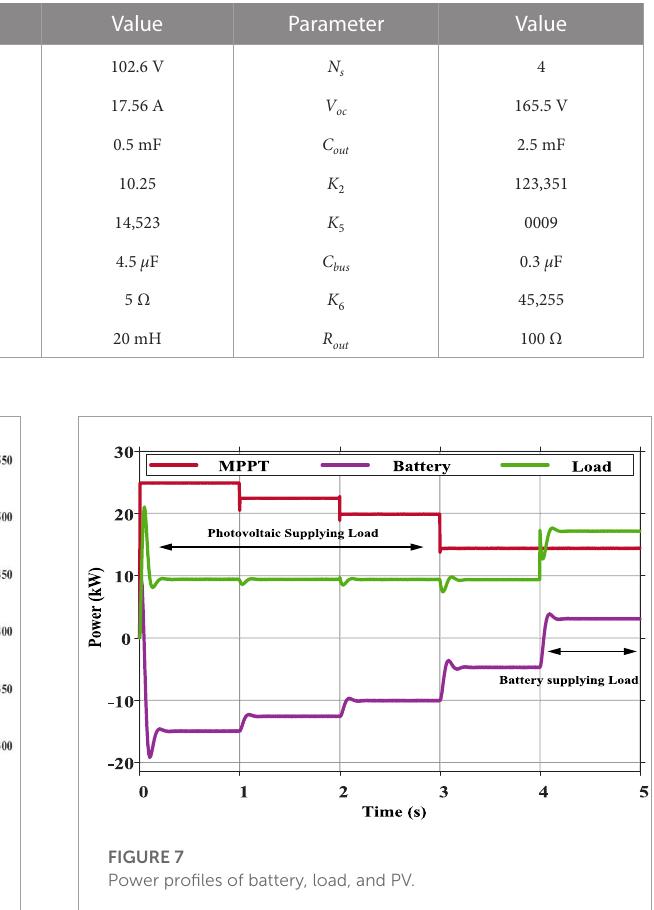
At initial steady state, PV panel is producing 25 kW and load power consumption is 10 kW. The battery is in charging mode with 15 kW. The control law in (33) determines the desired PV voltage while BRTA extracts maximum power point by tracking the desired PV voltage obtained by linear regression method. System performance is studied through the following changes.